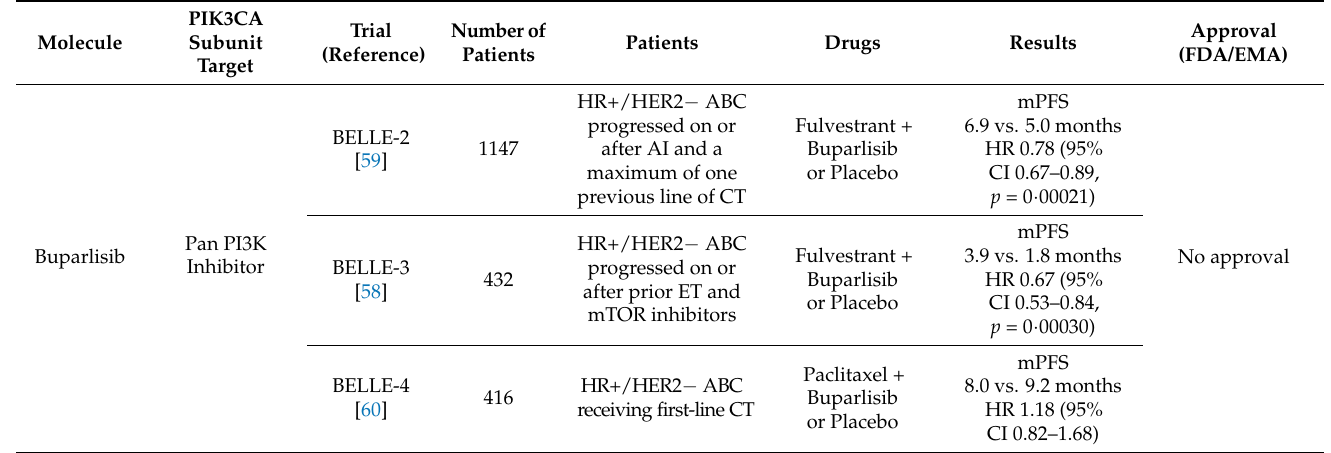
Table 1 summarizes the phase III trials with PI3K inhibitors in advanced BC. Table 1. Phase III clinical trials of main PI3K inhibitors in breast cancer and